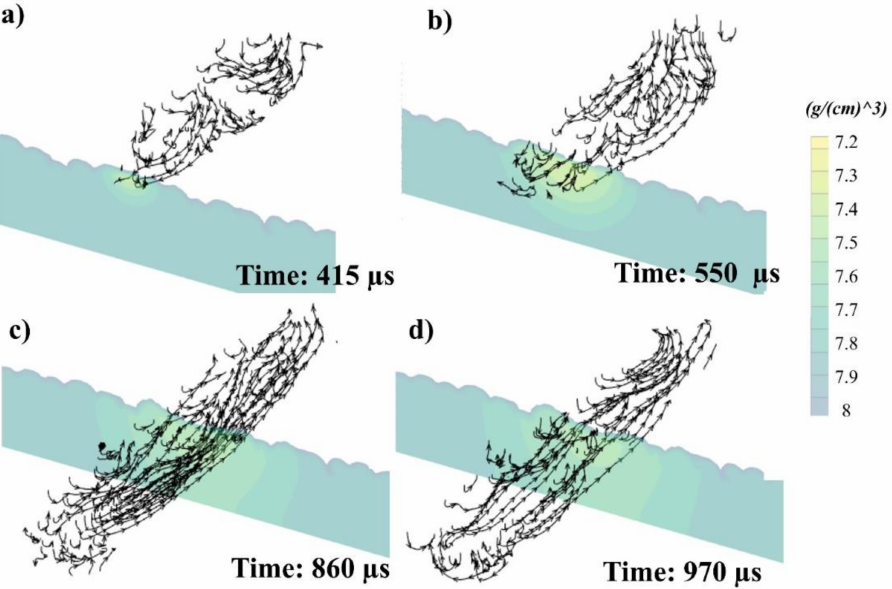
Figure 14. Stream traces with directions passing through the cross-section at ( a ) 415, ( b ) 550, ( c ) 860, and ( d ) 970 µ